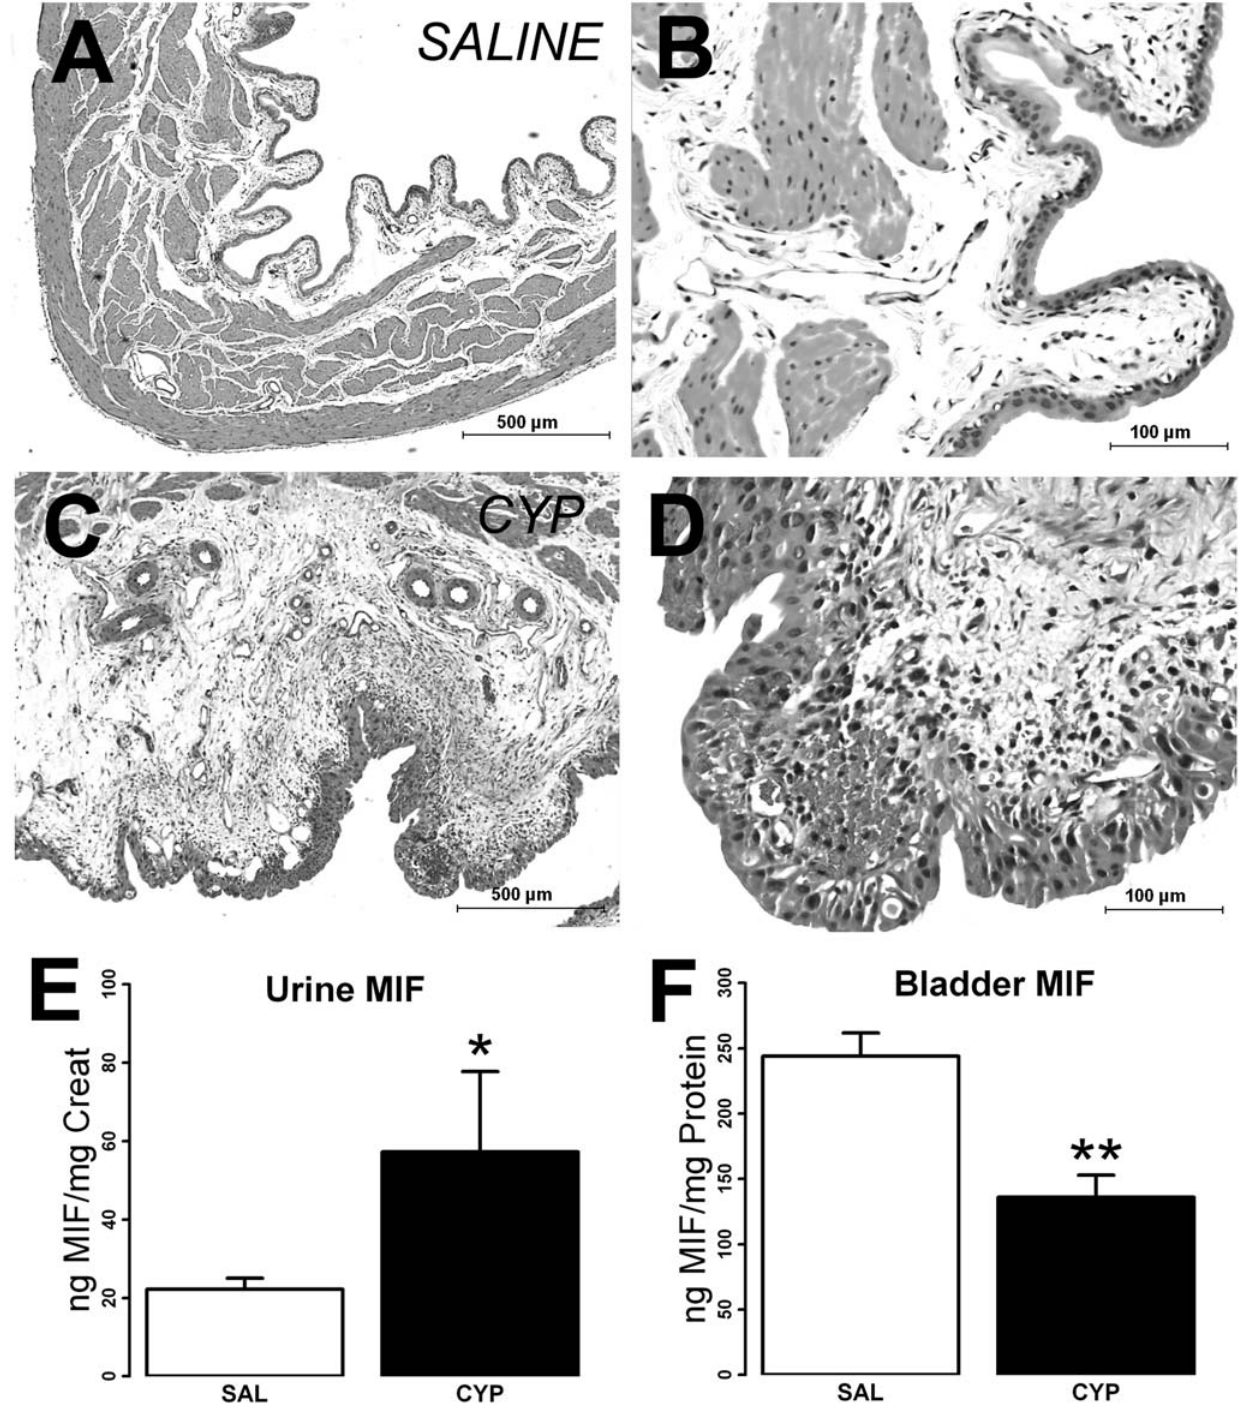
Figure 1. Effect of cyclophosphamide (CYP) treatment on bladder histology, bladder and urine MIF levels. Bladder paraffin sections stained with H&E showed normal morphology, as represented in A,B. CYP treatment however, caused significant edema and chronic inflammation (C,D), and some bladders had acute inflammatory cells. Asterisks in C,D mark areas of edema and high numbers of cellular infiltrates. Urothelial hyperplasia was also observed. In addition, urinary MIF levels were increased by CYP treatment (E; *=p , 0.05), while bladder MIF levels were increased by CYP treatment (F; **=p , 0.01). Calibration bar: 1A,1C=500 m m; 1B,1D=100 m m.